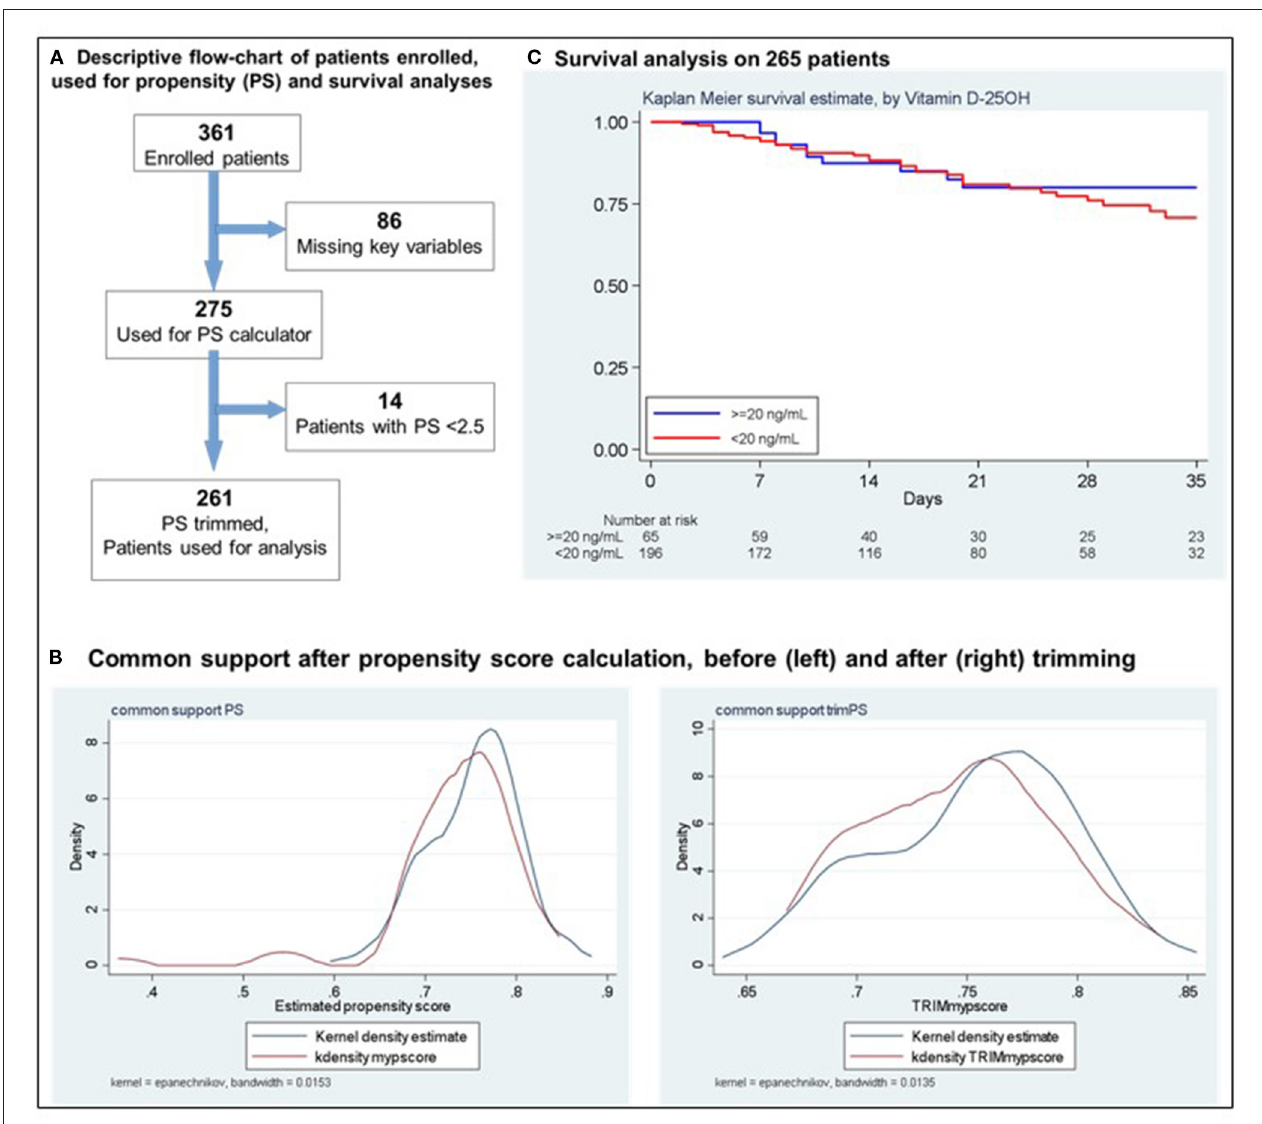
FIGURE 1 | (A) Descriptive flow-chart of patients enrolled used for propensity (PS) and Survival analyses. (B) Common support after propensity score calculation, before (left) and after (right) trimming. (C) Survival analysis on 265